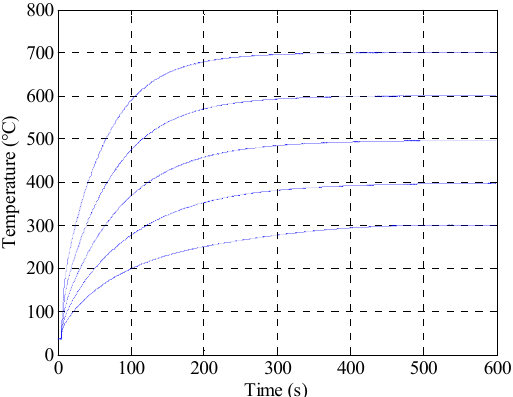
Figure 8. Output signals of the thermocouple at different furnace temperatures.